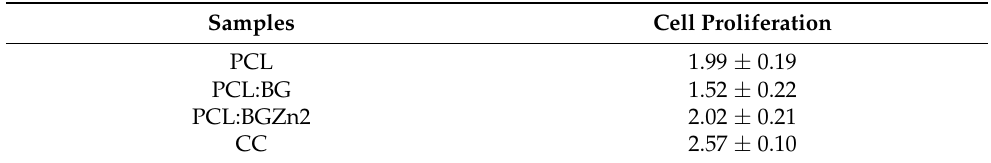
Figure 10. Saos-2 adhesion and proliferation rate for 1, 3 and 7 days in PCL, PCL:BG and PCL:BGZn2 membranes (*** p < 0.005). Table 1. Cell proliferation evaluation for the composite membranes with the ratio between cell population on day 7 and on day 1.